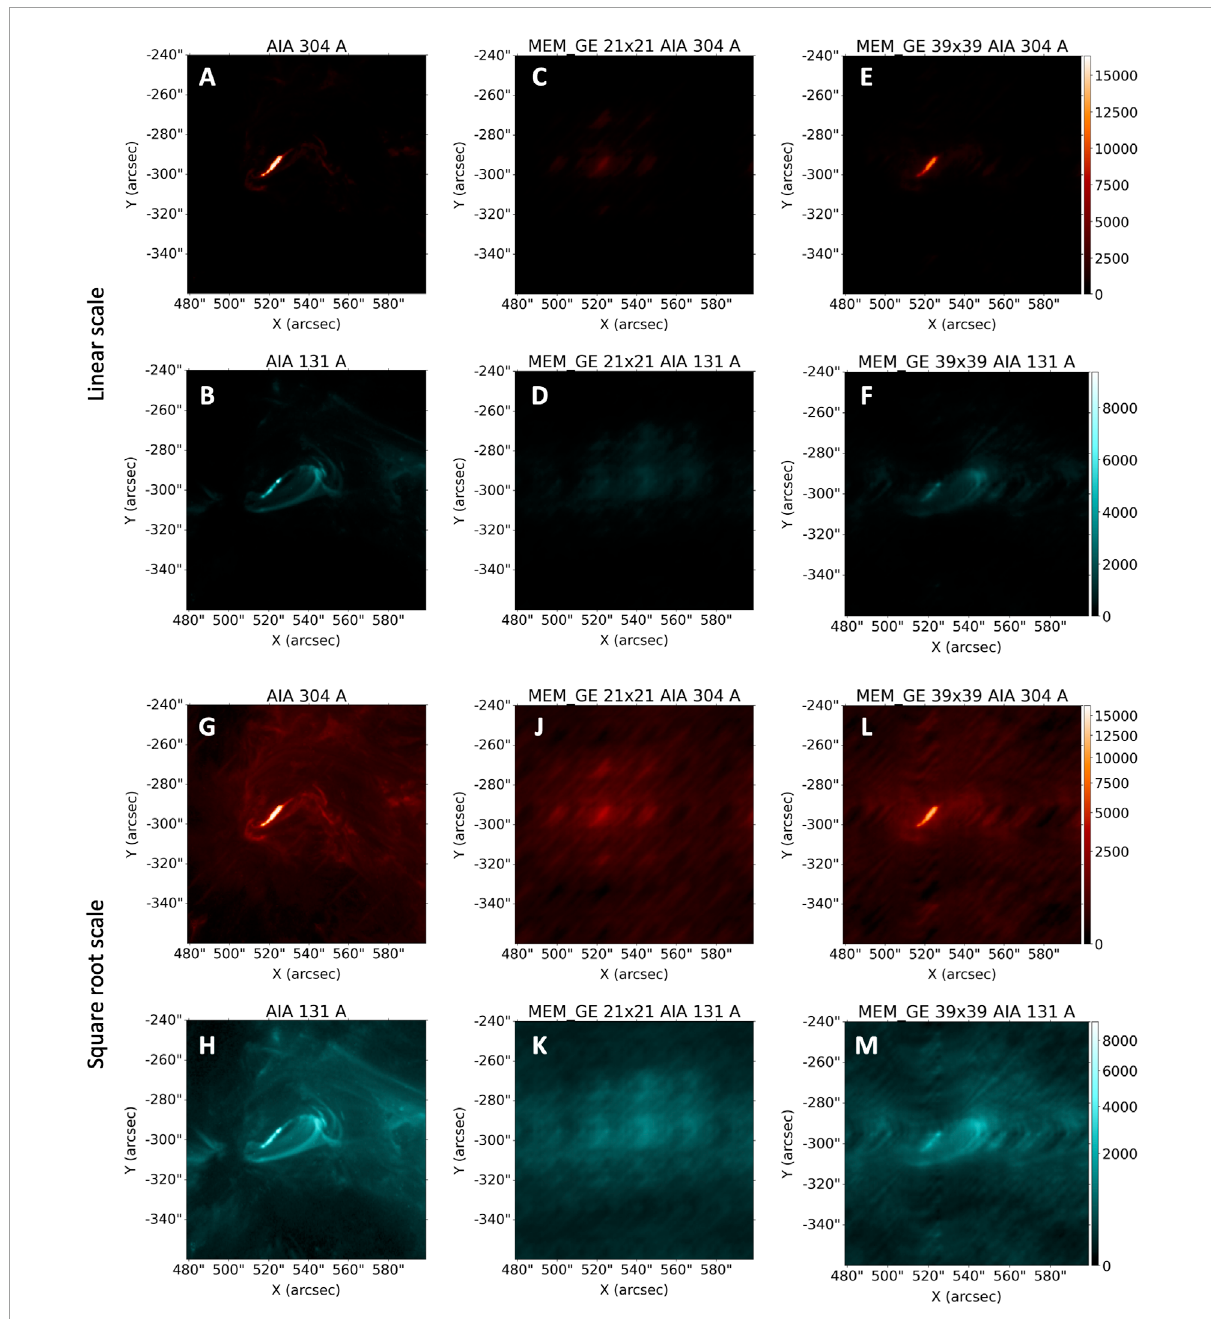
FIGURE 6 Reconstructed images using the visibility maps of Figure 5 (including the associated phases, see text for details) and the MEM_GE algorithm. (A and B) original images; (C and D) reconstructed images using 21 × 21 visibility points (panel (A) of Figure 4 ); (E and F) reconstructed images using 39 × 39 visibility points (panel (B) of Figure 4 ). (G–M) show the same information, with a square root intensity scaling applied to provide greater detail on relatively weak pixels. The color map is shared by panels in the same